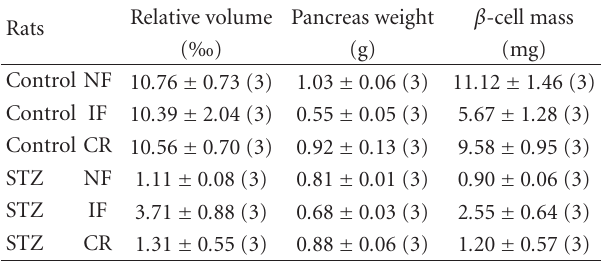
Table 5: Relative and absolute values for total β -cell mass. Rats